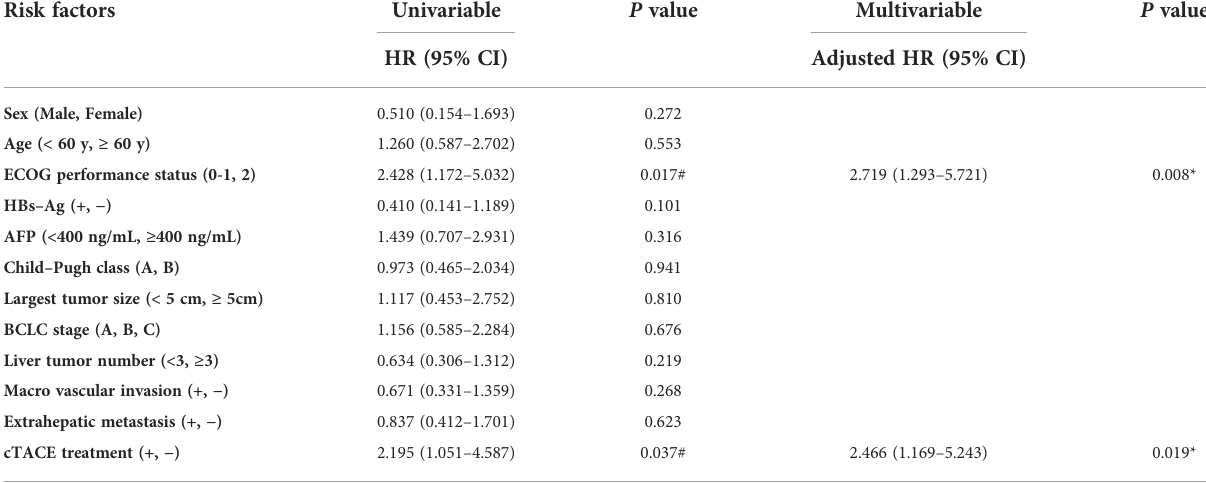
TABLE 4 Potential risk factors for PFS across the entire